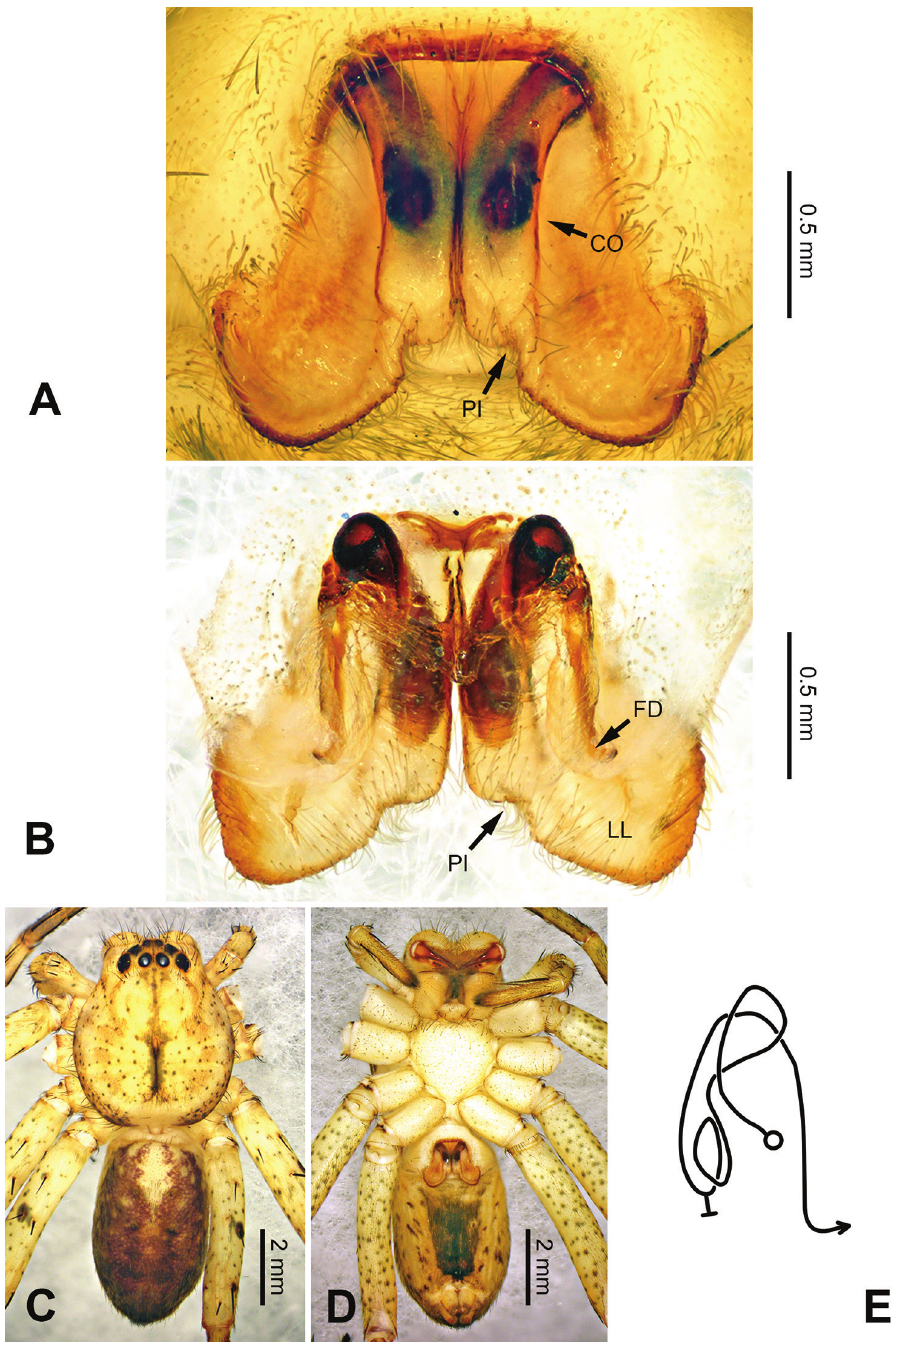
Figure 5. Pseudopoda colubrina Zhao & Li, sp. n., paratype female. A Epigyne, ventral view B Vulva, dorsal view C Habitus, dorsal view D Habitus, ventral view E Schematic course of internal duct system, dorsal